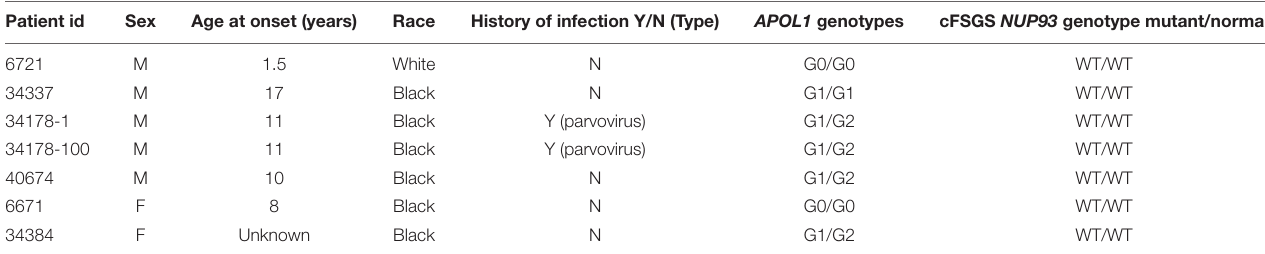
FIGURE 3 | (A) Two rare variants in NUP93 gene segregate with disease in two brothers with cFSGS, (B) the two variants are conserved in evolution down to zebrafish, (C) the 3D structures for the wild type (WT) NUP93 protein (left), the G591V variant (middle) and the L695S variant (right) showing structural changes in the amino terminus (blue) to the carboxyl terminus (red) in the two variants compared with the WT, (D) the top predicted ligands for WT NUP93 (top), G591V (middle) and L695S (bottom). The top two predicted ligands for WT NUP93, Acetyl-coenzyme A carboxylase (RCP, yellow) and Apaf-1 (GBL, orange) are disrupted in the G591V variant and L695AS variant, respectively. TABLE 2 | APOL1 and NUP93 genotype in seven children with cFSGS